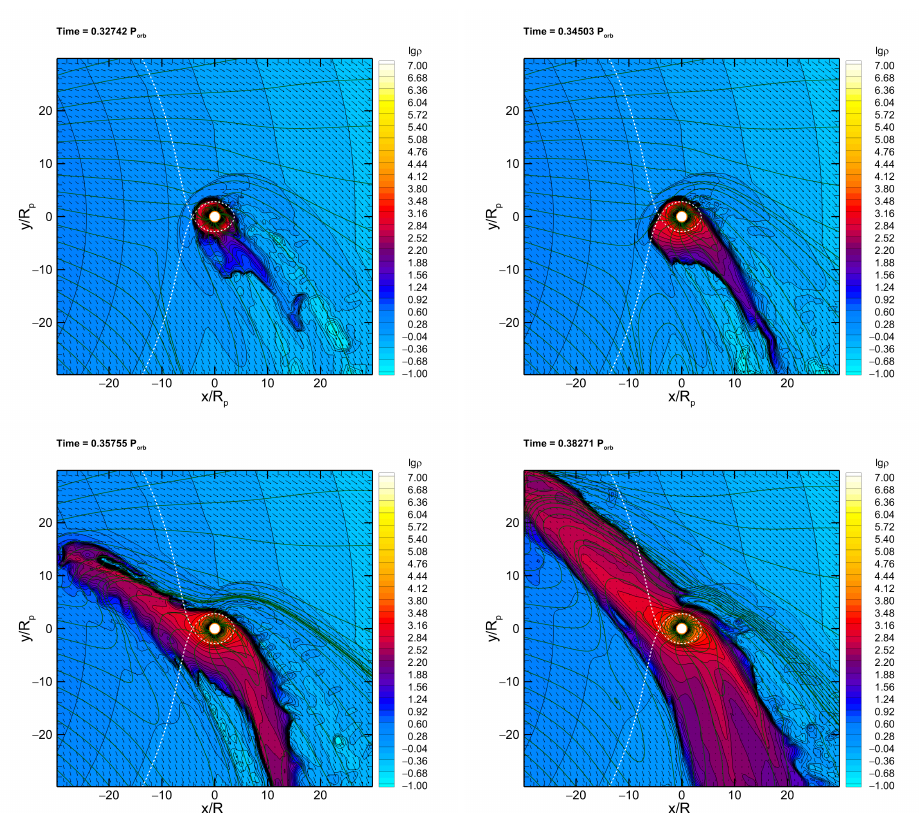
Figure 9. Distributions of density (color, iso-lines), velocity (arrows) and magnetic field (lines) in the orbital plane at a time moment approximately equal to a one third of the orbital period for models 1 ( T a = 5000 K, top left), 2 ( T a = 5500 K, top right), 3 ( T a = 6000 K, bottom left) and 4 ( T a = 6500 K, bottom right). The density is expressed in units of ρ w . The dotted line shows the border of the Roche lobe. The white circle corresponds to the photometric radius of the